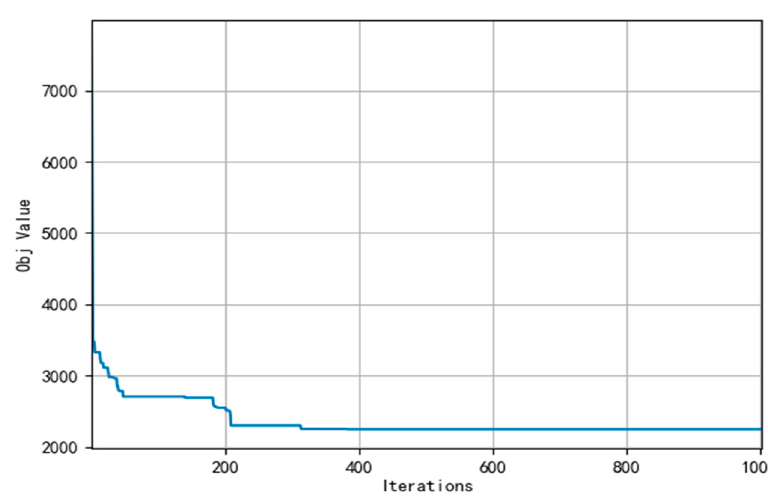
Figure 8. Convergence curve of ALNS.